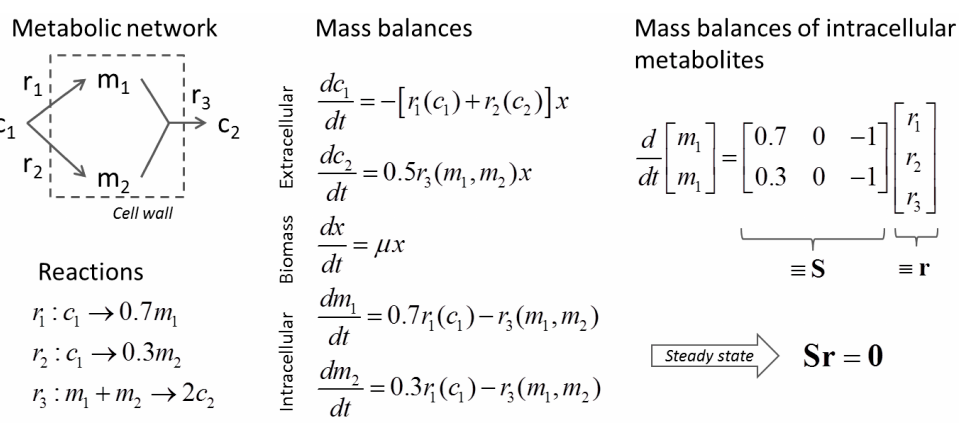
Figure 3. Graphical and mathematical representations of metabolic reactions occurring in a